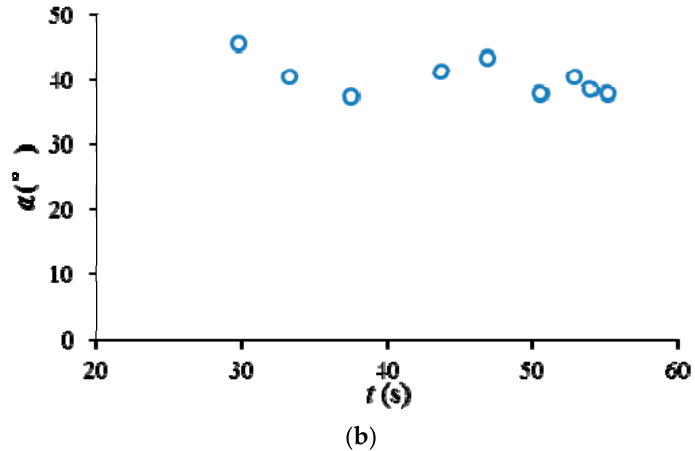
Figure 5. Variation of the scour front angle with time in the scour process: ( a ) Variation of the scour front pattern; ( b ) variation of the scour front angle.